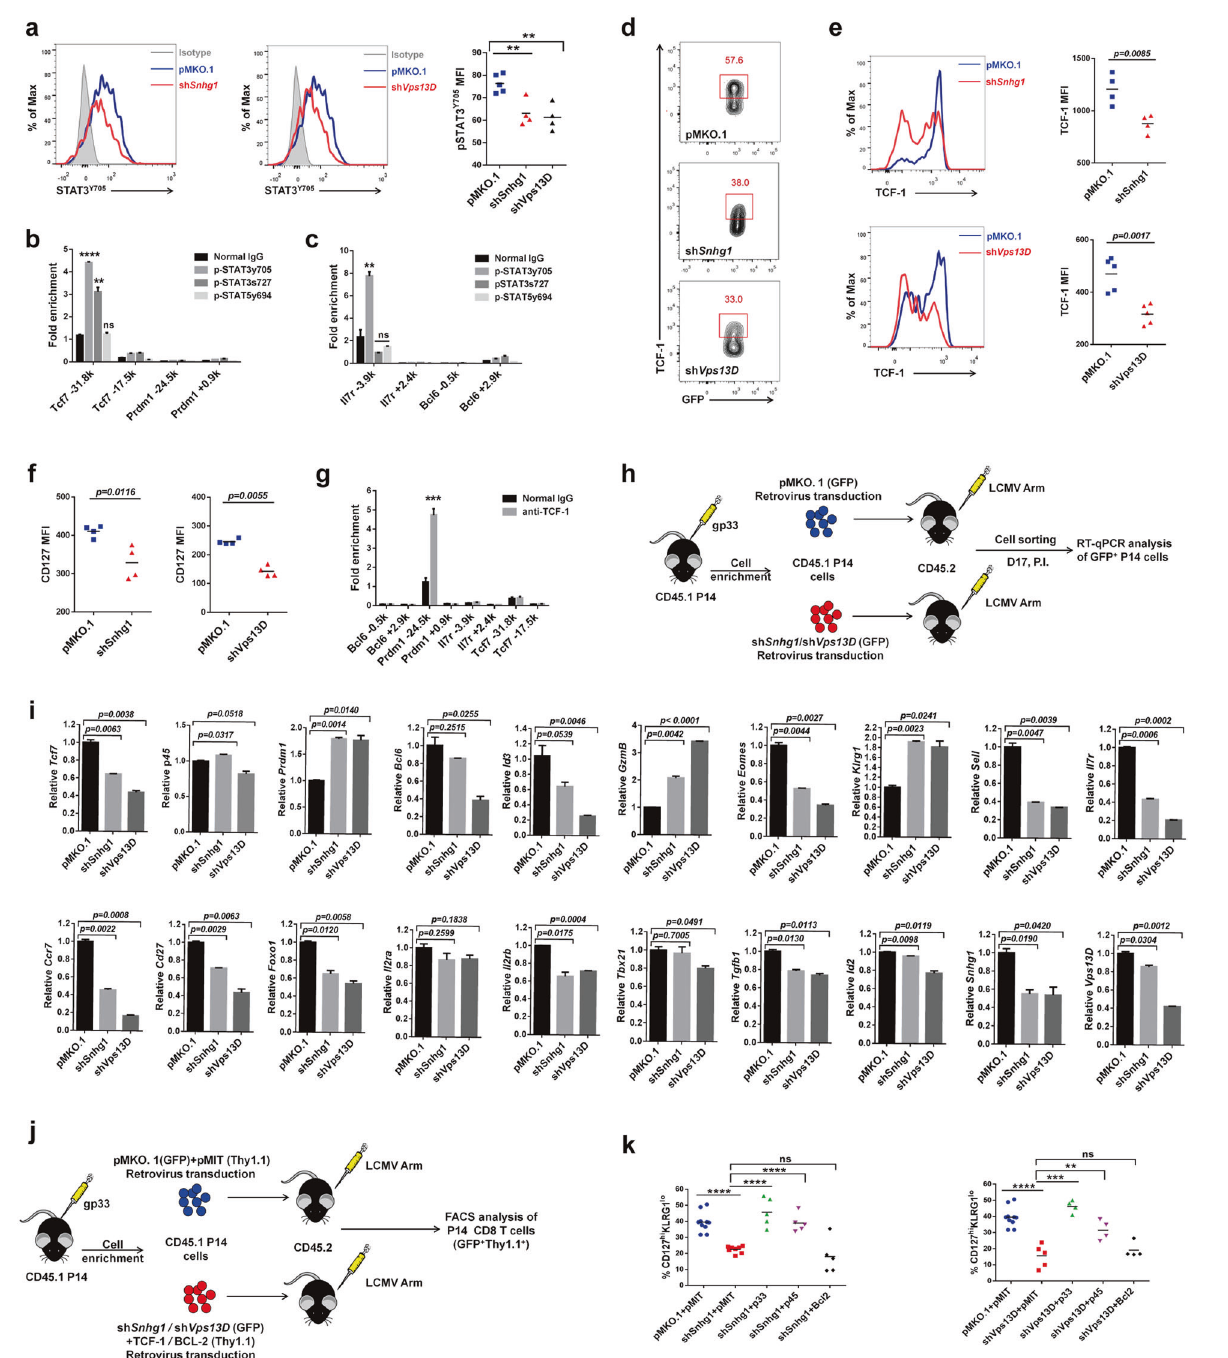
Fig. 6 Snhg1/Vps13D depletion impairs transcriptional launch program of memory CD8 T cells through IL-7-STAT3-TCF1-Blimp1 axis. Expression and quanti fi cation of p-STAT3 Y705 in pMKO.1/sh Snhg1 /sh Vps13D GFP + P14 CD8 T cells on day 15 p.i. b , c ChIP assay of Rabbit anti- p-STAT3 Y705 , p-STAT3 S727 and p-STAT5 Y694 to the indicated genes, compared with normal Rabbit IgG, in CD8 T cells stimulated with IL-7. d Flow cytometry of the proportion of TCF-1 + cells in pMKO.1/sh Snhg1 /sh Vps13D GFP + P14 CD8 T cells on day 35 p.i. e Expression and quanti fi cation of TCF-1 in pMKO.1/sh Snhg1 /sh Vps13D groups on day 35 p.i. f MFI of total CD127 (staining with cell punching buffer) in pMKO.1/sh Snhg1 / sh Vps13D groups on day 15 p.i. g ChIP assay of Rabbit anti- TCF-1 to the indicated genes, compared with normal Rabbit IgG, in CD8 T cells stimulated with IL-7. h , i The established GFP + P14 CD8 T cells were sorted as indicated ( h ) for RT-qPCR analysis of indicated genes on day 17 p.i. ( i ). j , k LCMV-infected mice with pMKO.1/sh Snhg1 /sh Vps13D (IRES- GFP ) and pMIT/ Tcf7 / Bcl2 (IRES -Thy1.1 ) co-transducted together as indicated ( j ). FACS analysis of CD127 hi KLRG1 lo cells in double-positive (GFP + Thy1.1 + ) P14 CD8 T cells were performed on day 35 p.i. ( k ). Data are representative of two or three independent experiments with at least three replicates or four mice per group (error bars denote s.e.m.). ns, not signi fi cant; * p < 0.05, ** p < 0.01, *** p < 0.001, **** p < 0.0001 (unpaired two-tailed t -test). See also Fig. S6, Tables S1,